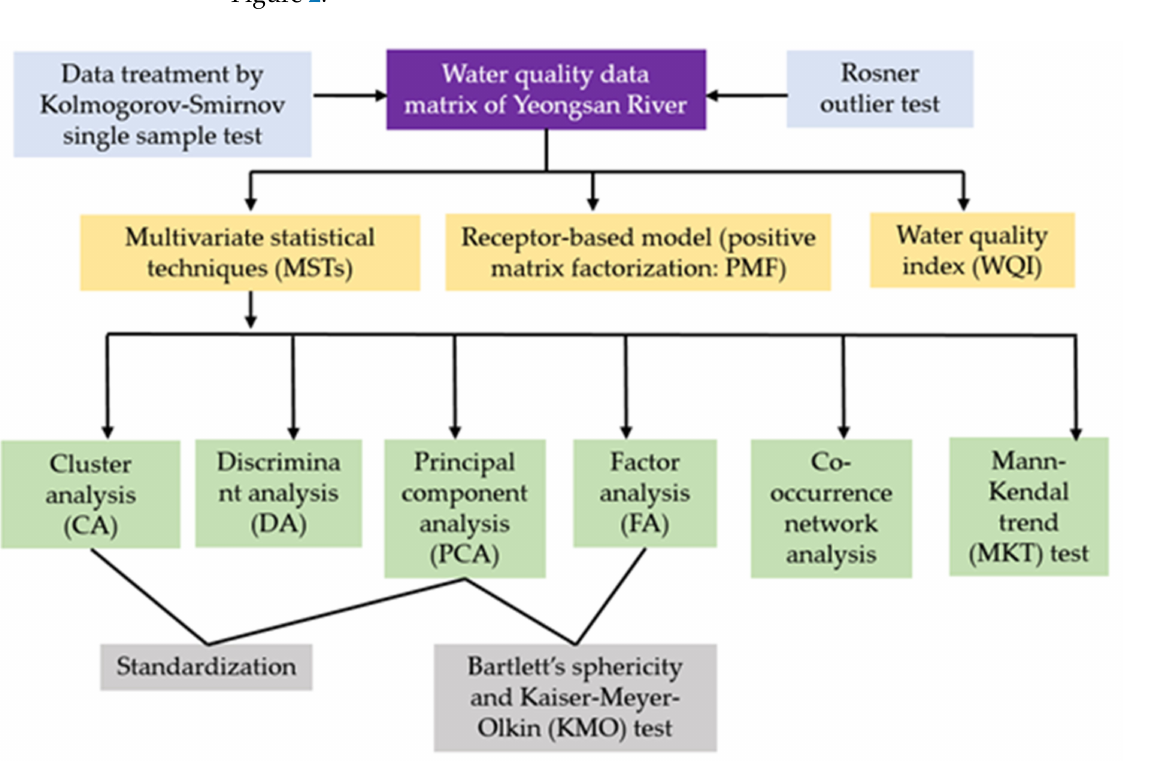
Figure 2. Methodological flow chart of the Yeongsan River data